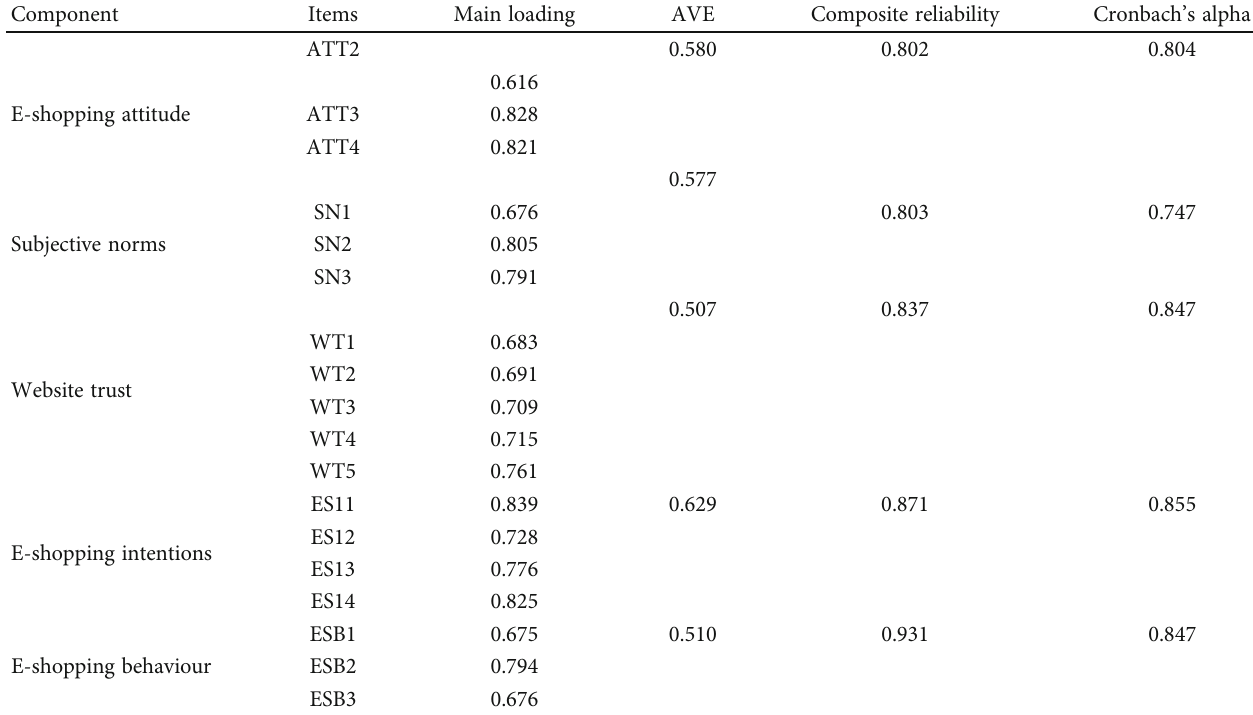
Table 1: Measurement model result